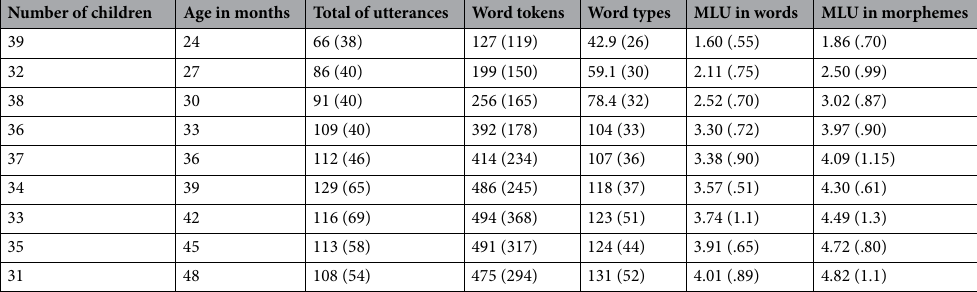
Table 1. Descriptive summary of the corpora (mean and standard deviation of raw number).